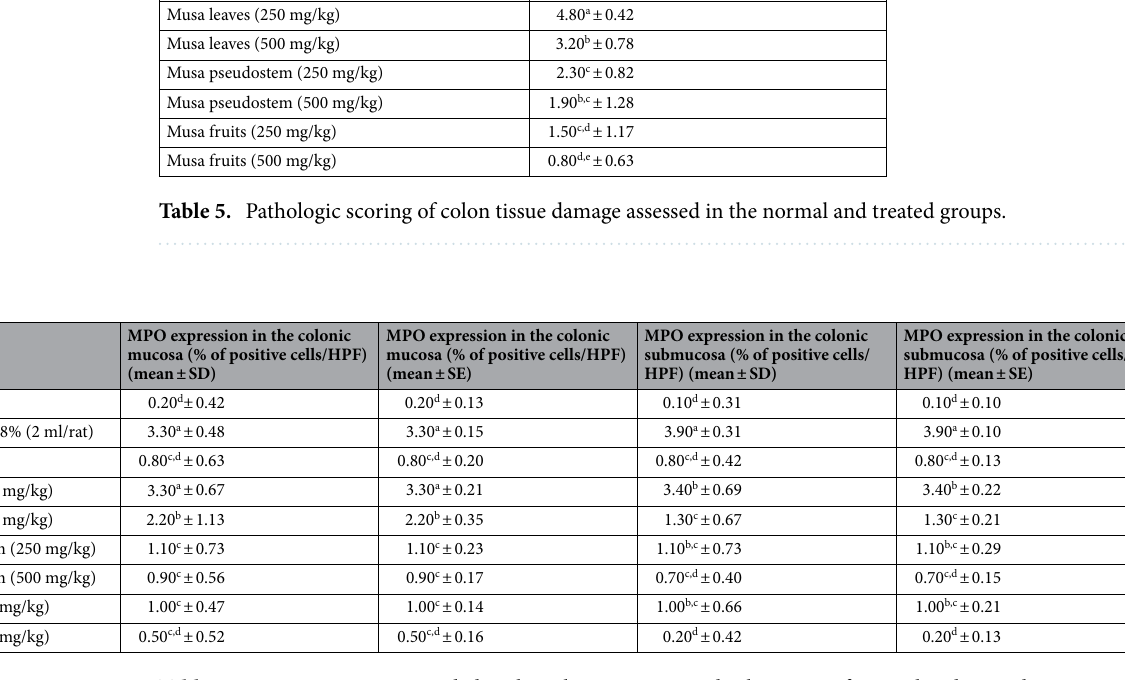
Table 6. MPO expression recorded in the colonic mucosa and submucosa of normal and treated groups. Results are expressed as means of MPO positive cells ± SE. a Significantly different from negative control group, b Significantly different from prednisolone group, c Significantly different from Musa leaves high dose, d = Significantly different from positive control